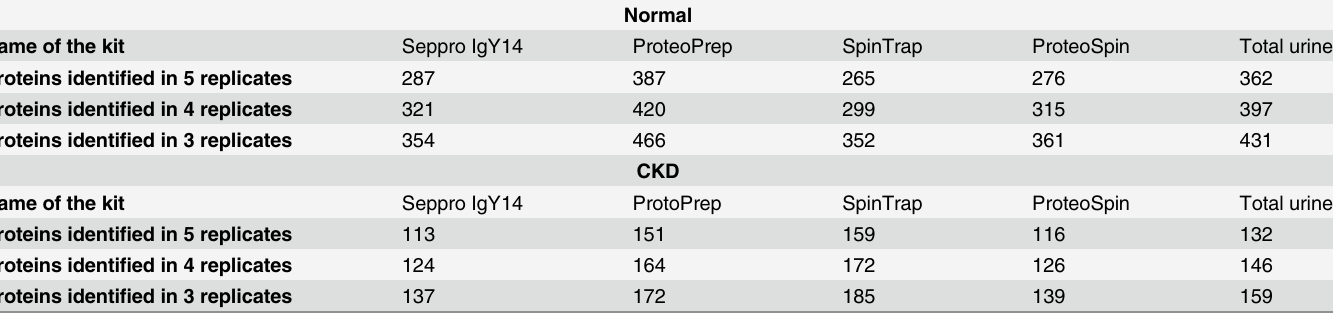
Table 3. Total number (sum) of identified proteins per depletion strategy for normal and CKD sample (in at least 3, 4 and 5 technical replicates). For both depleted and non-depleted sample the number of identifications is higher in normal than in CKD urine.